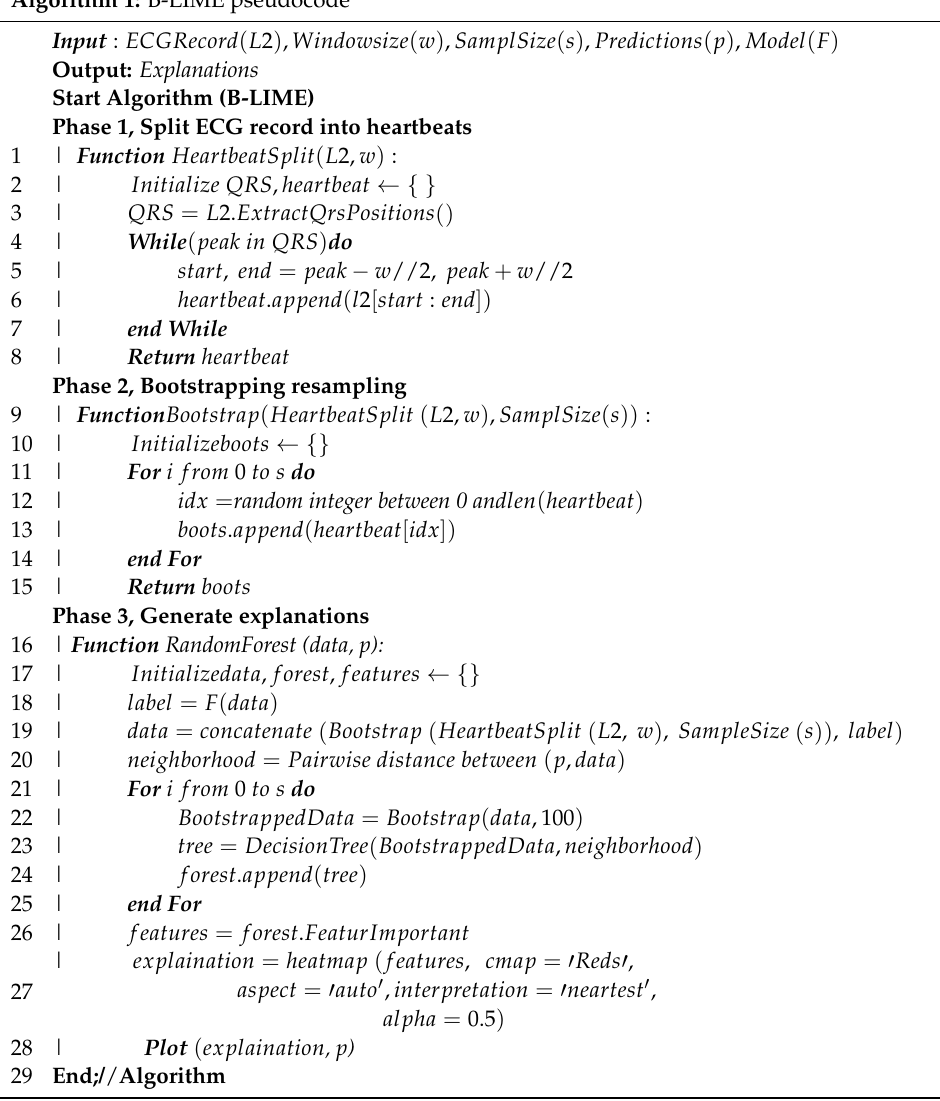
Algorithm 1: B-LIME